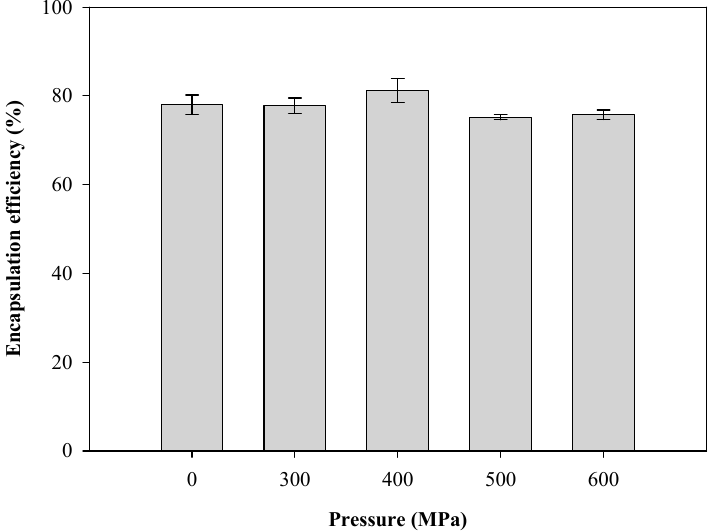
Figure 5. Effect of pressure on encapsulation efficiency of CTP liposomes prepared by the HPP method.